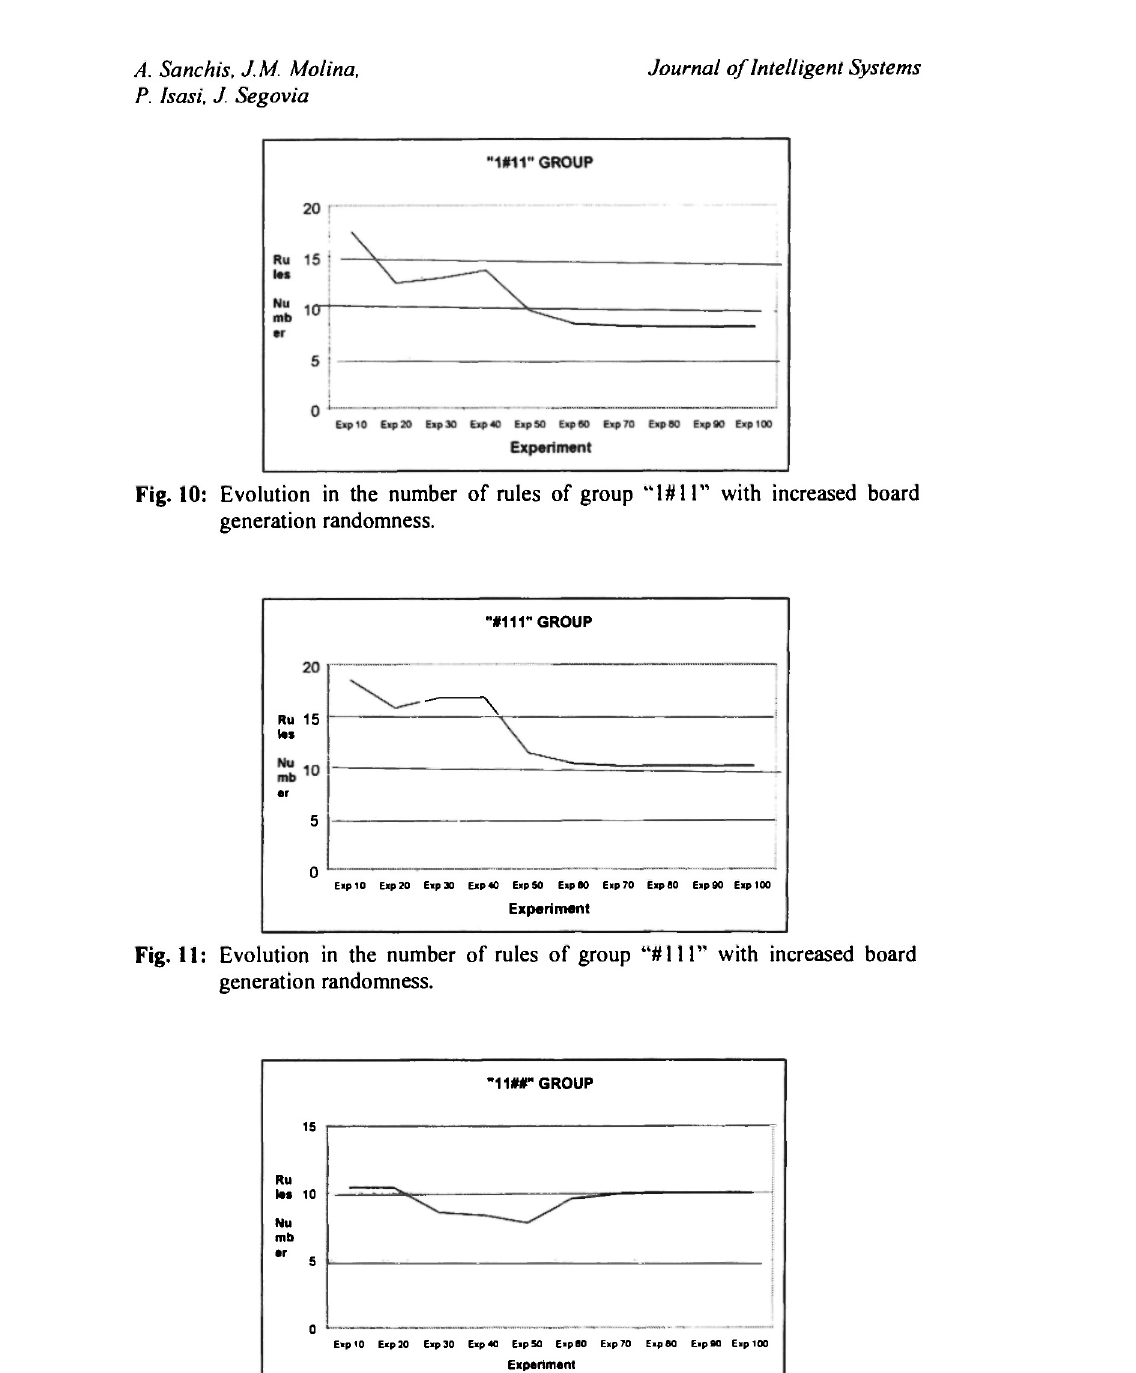
Fig. 12: Evolution in the number of rules of group "ll##" with increased board generation